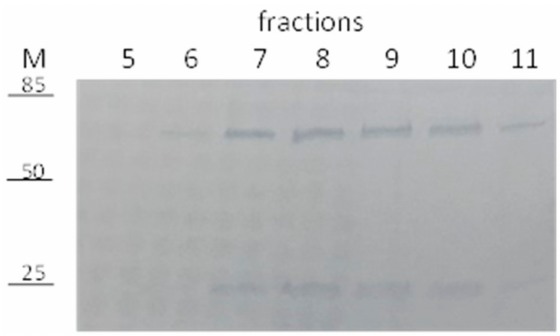
Figure 3. SDS-PAGE of 5–11 fractions